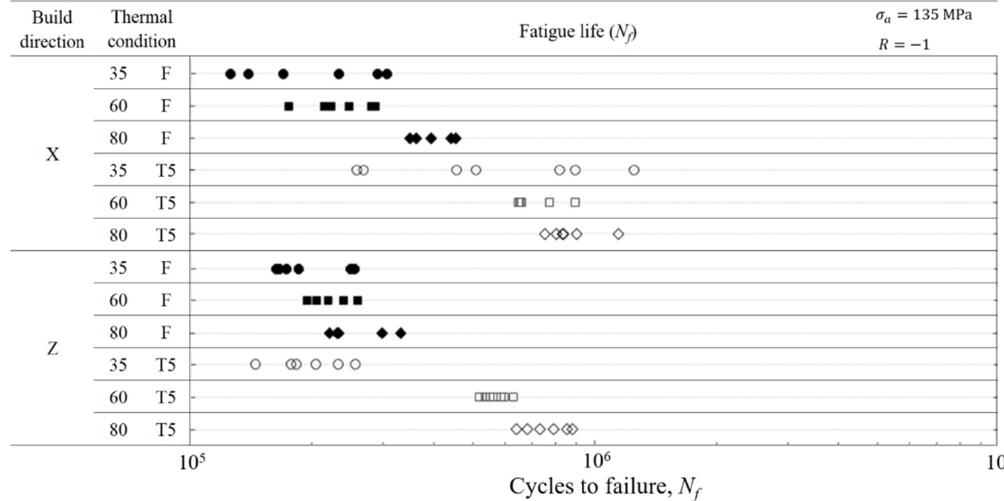
Figure 10. Fatigue life from rotating-bending fatigue tests at 130 MPa for 200 °C condition (X and Z building conditions). Figure 9. Fatigue life from rotating-bending fatigue tests at 135 MPa for 35 ◦ C, 60 ◦ C and 80 ◦ C conditions (X and Z Figure 9. Fatigue life from rotating-bending fatigue tests at 135 MPa for 35 °C, 60 °C and 80 °C building conditions). conditions (X and Z building conditions).